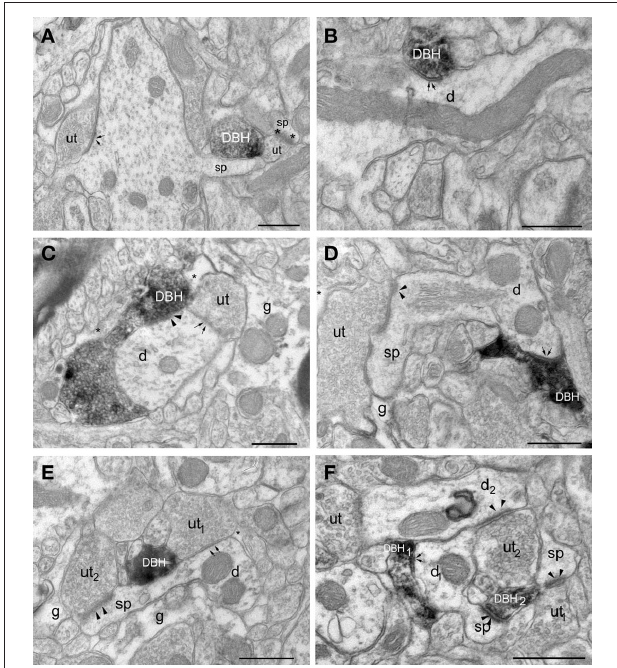
Figure 3 | electron micrographs show D β H-terminals in LA. (A) A D β H – terminal (DBH) apposes a dendritic spine (sp) and an unlabeled terminal (ut) forming an asymmetric synapse (asterisks) onto a spine (sp). (B) A D β H-terminal forms a symmetric synapse (arrows) with a dendrite (d). (C) A D β H-terminal forms a synapse (arrowheads) onto a dendrite (d) that also receives a synapse (arrows) from an unlabeled terminal (ut). Glial processes (g and asterisk) are also shown. (D) A DBH-terminal forms a symmetric synapse (arrows) onto a dendritic (d) whose spine (sp) receives a synapse (arrowheads) Figure 4 | D β H-profiles and glial processes immunoreactive for β Ar 404 from an unlabeled terminal (ut). Also shown is a glial process (g). (e) A are associated with blood vessels. (A) A D β H-axon (LAx) follows the D β H-terminal is apposed to an unlabeled terminal (ut ) that forms a symmetric 1 contours of a blood vessel. The plasma membrane of the D β H-terminal (D β H) synapse (arrows) on a dendrite (d). An unlabeled terminal (ut ) forms an 2 shows parallel alignment with the plasma membrane (small arrows) of an asymmetric synapse (arrowheads) on the dendrite’s spine (sp). Unlabeled glial unlabeled terminal (ut). The basal lamina (asterisks) and an endothelial cell processes (g and *) are also shown. (F) A D β H-terminal (DBH ) forms a 1 (End) separate the D β H-terminal from the blood vessel (BV). (B) A β AR synapse (arrows) onto a dendritic shaft (d ), whose spine (sp) receives an 1 404-labeled glial process (LG) encircles a blood vessel (BV), which is bounded asymmetric synapse (arrowheads) from a second D β H-terminal (DBH ). D β H 2 2 by an endothelial cell (end) and the basal lamina (asterisks). The β AR 404 apposes unlabeled terminals (ut astrocyte apposes unlabeled terminals (ut), one of which forms an asymmetric synapse (arrowheads) onto a dendritic spine (sp). Scale bars = 0.500 μm.